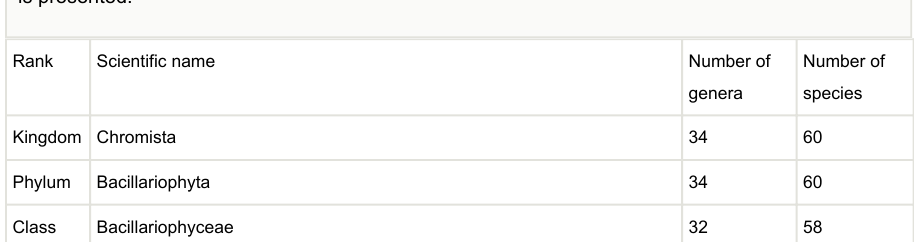
Taxonomic coverage of the data. The number of genera and species included in each higher taxon is